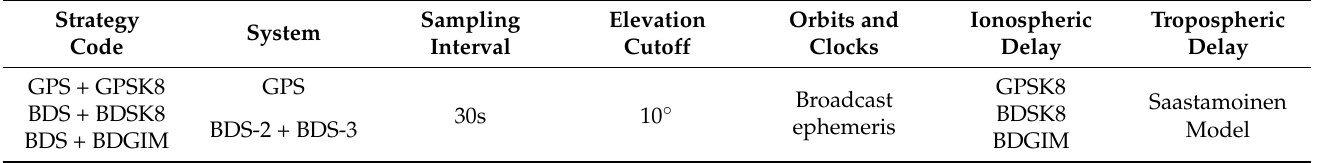
Table 2. The data processing strategies of static single-frequency SPP.